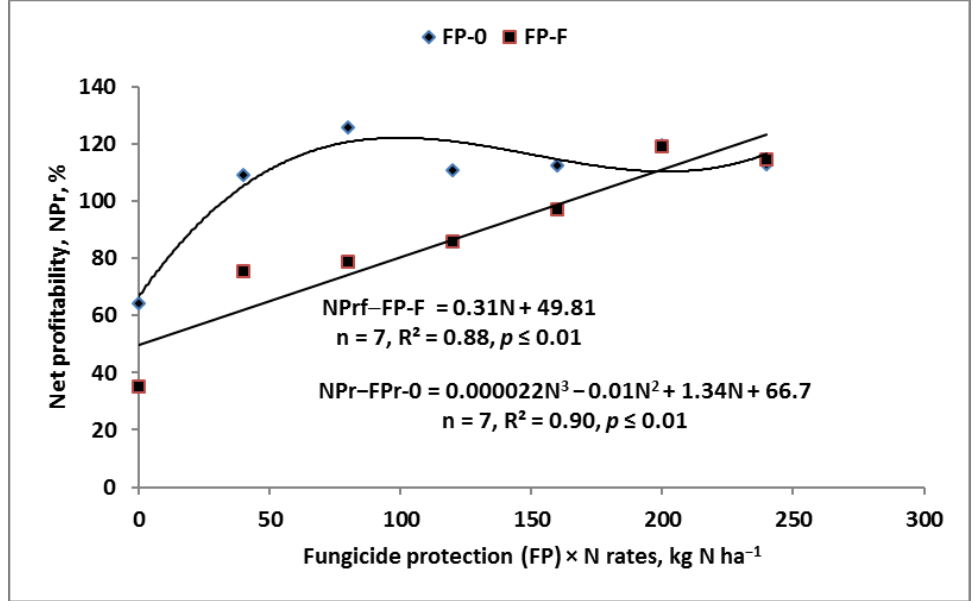
Figure A4. Regression models of net profitability response to increasing rates of fertiliser nitrogen on the background of winter wheat protection with fungicides.